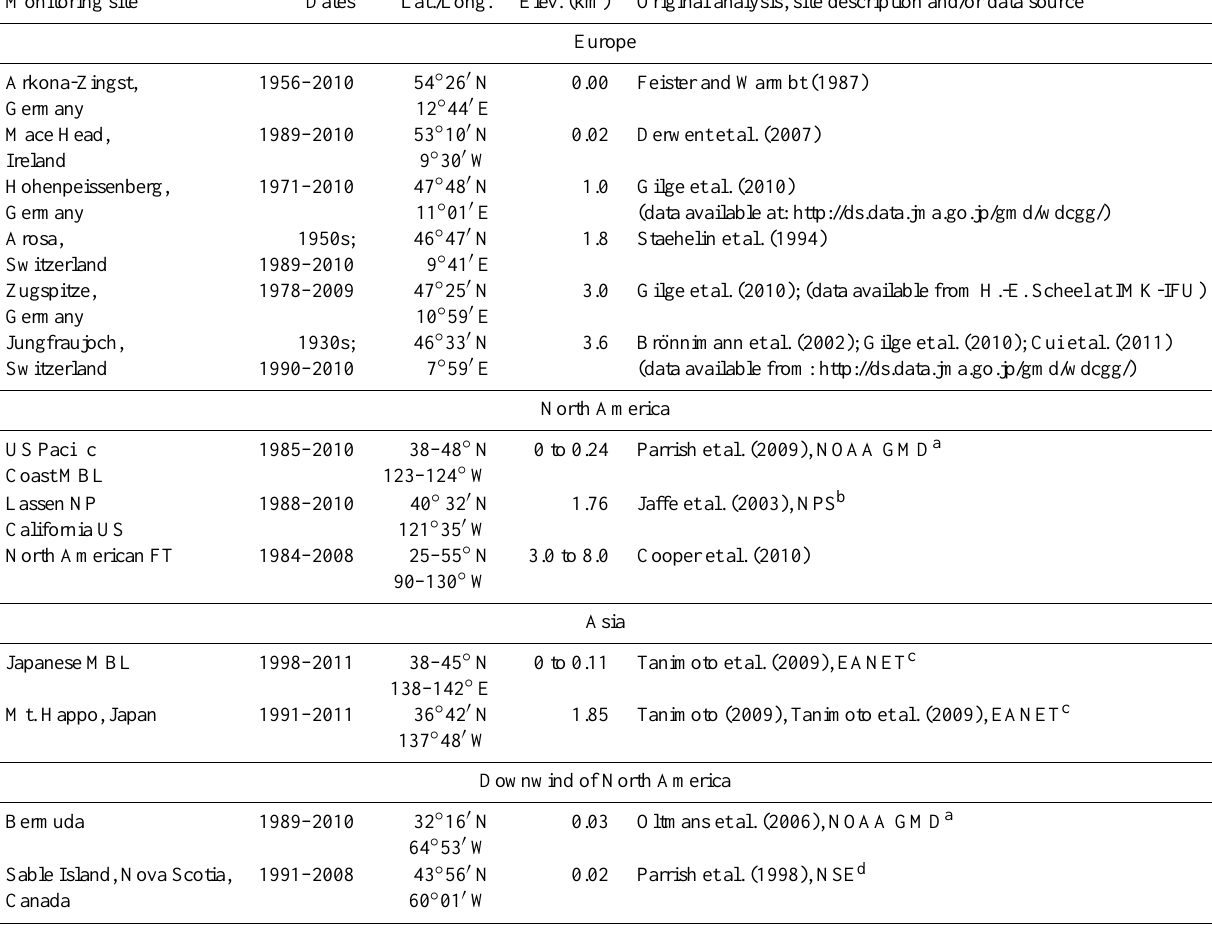
Table 1. Ozone data sets investigated in this